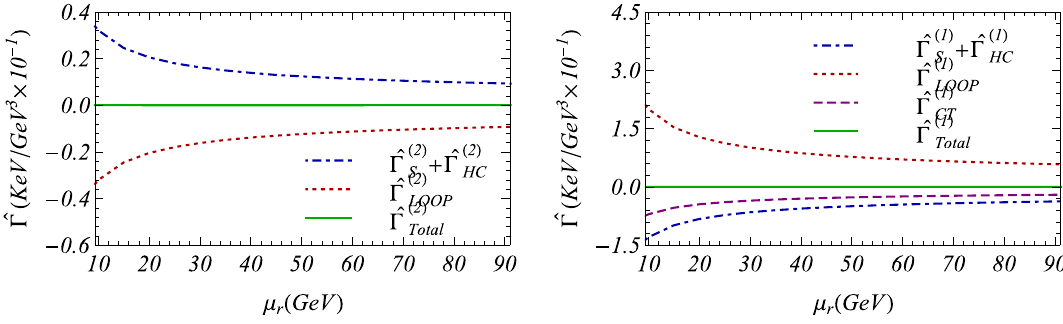
Fig. 2 Cancelation of the (cid:8) − 2 - and (cid:8) − 1 -order divergences. The superscripts “(2)” and “(1)” denote the (cid:8) − 2 - and (cid:8) − 1 -order terms, respectively